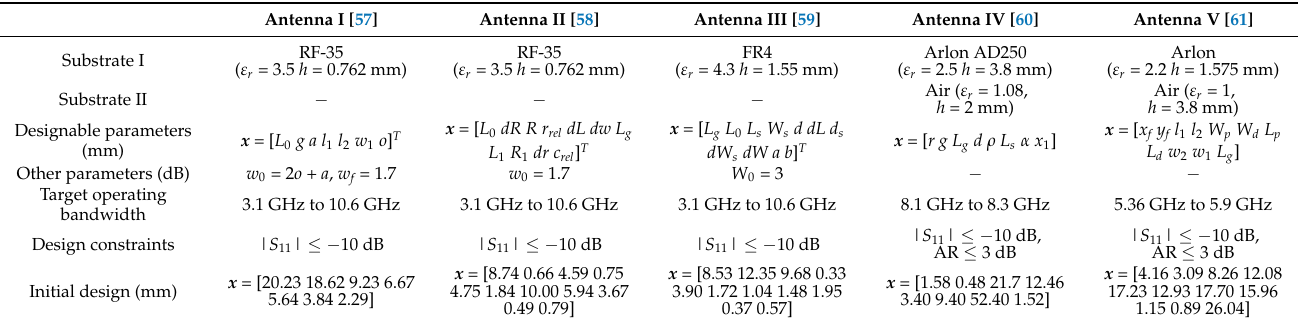
Table 1. Benchmark antenna